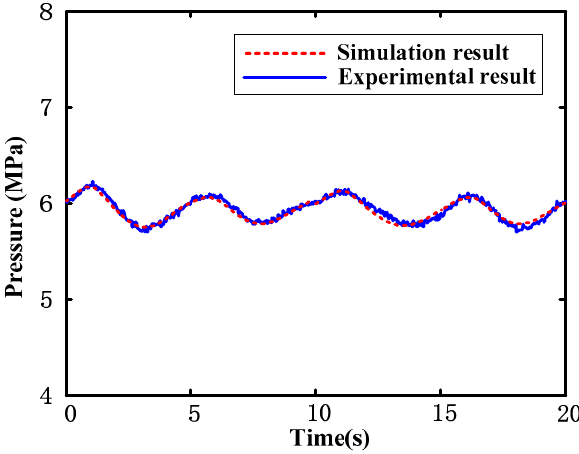
Figure 9. The pressure dynamic change curve of the hydraulic system.